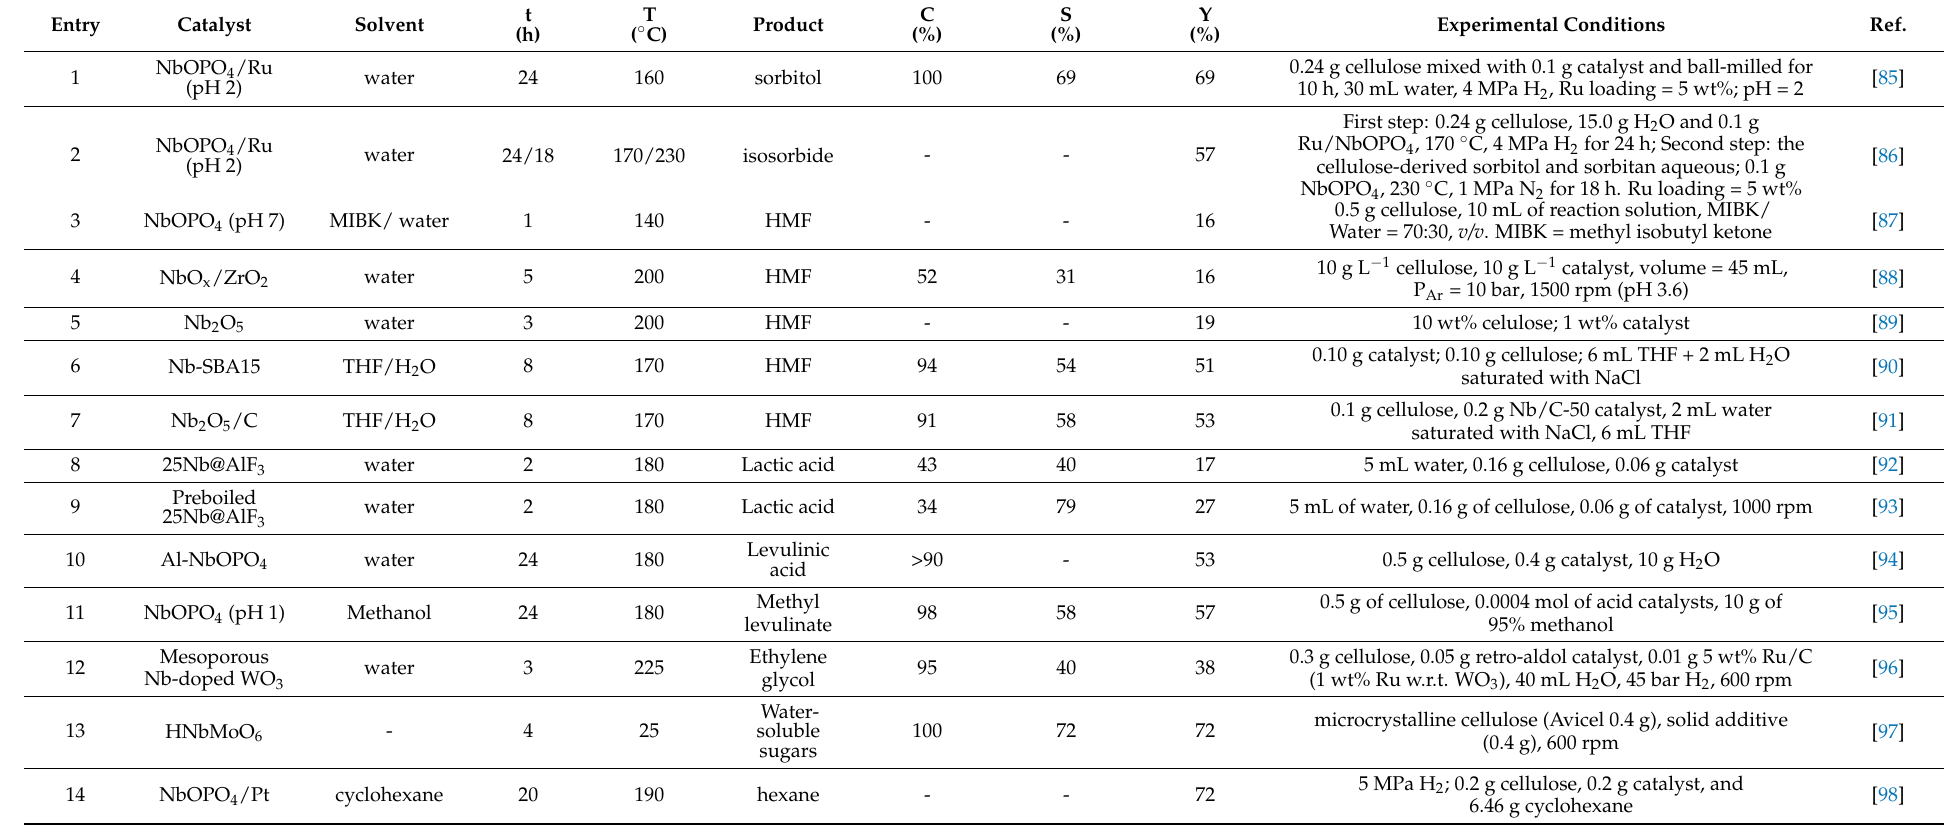
Table 2. Performance of niobium-based catalysts for conversion of cellulose into different products—from 2010 to